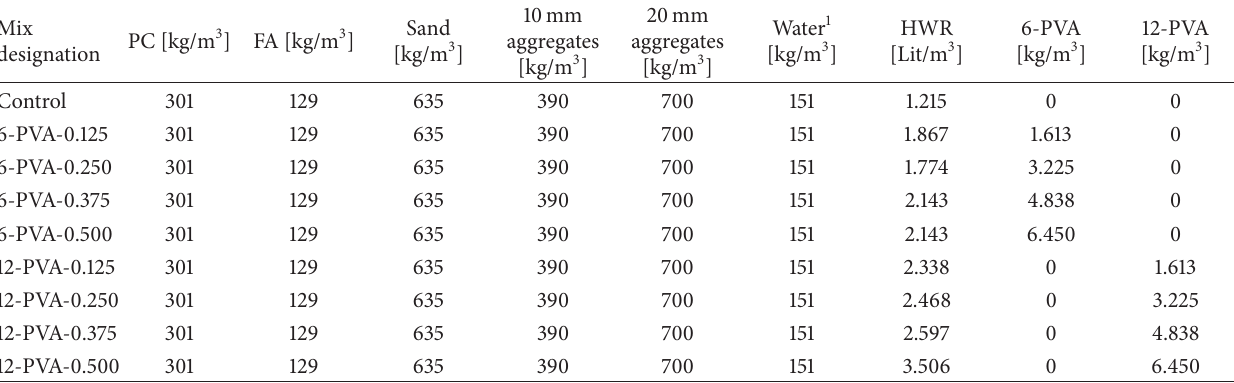
Table 4: Mix proportions.